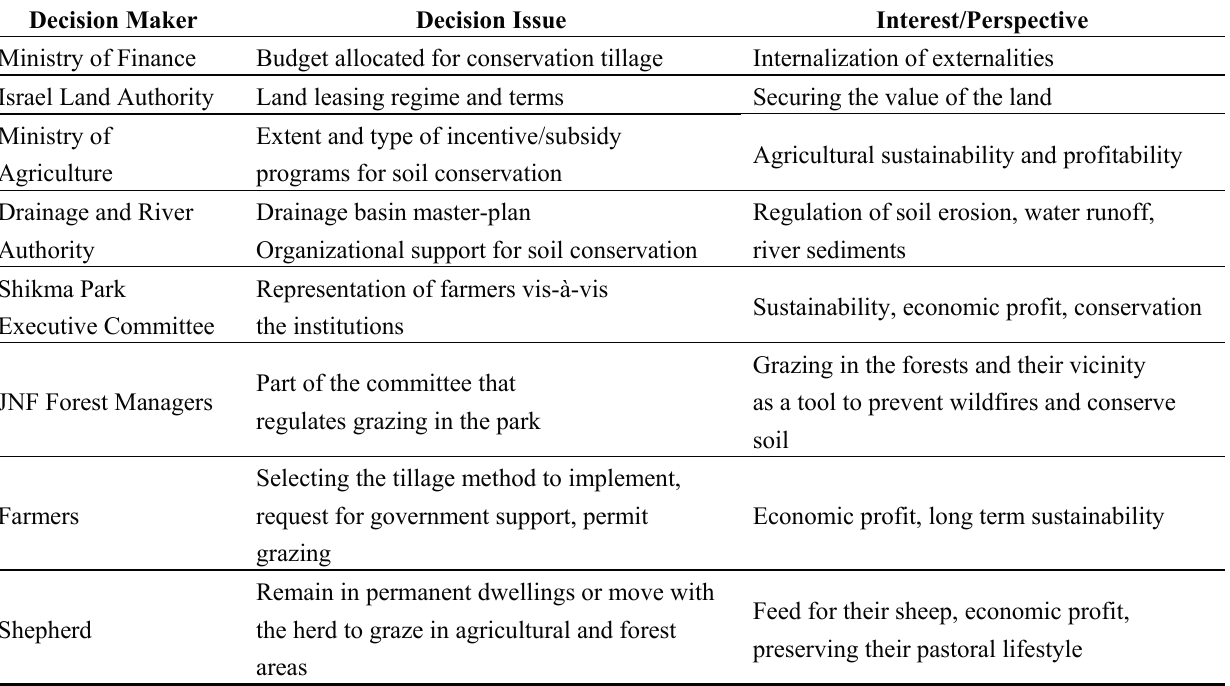
Table 1. Mapping decision makers and their point of